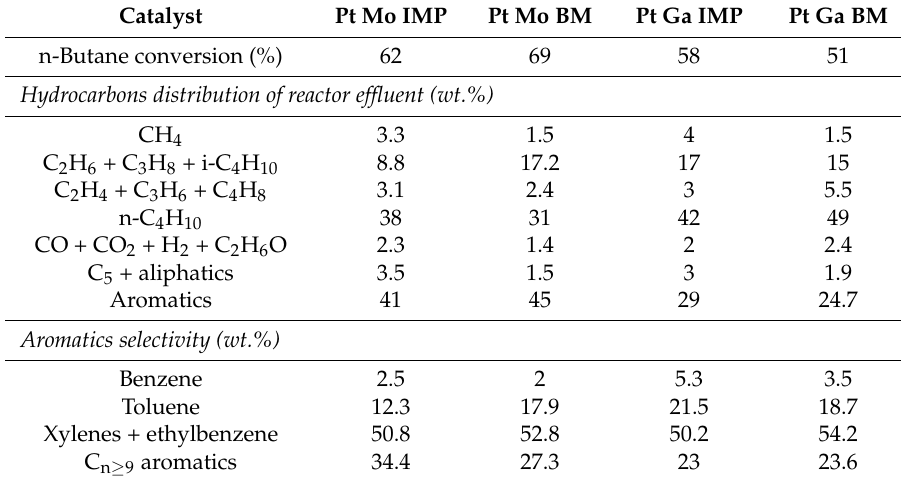
Table 2. Pt Mo/Ga catalysts performance in the aromatization of cofeeding n-butane with methanol. Catalyst Pt Mo IMP Pt Mo BM Pt Ga IMP Pt Ga BM n-Butane conversion (%) 62 69 58 51 Hydrocarbons distribution of reactor effluent (wt.%) CH 4 3.3 1.5 4 1.5 C 2 H 6 + C 3 H 8 + i-C 4 H 10 8.8 17.2 17 15 C 2 H 4 + C 3 H 6 + C 4 H 8 3.1 2.4 3 5.5 n-C 4 H 10 38 31 42 49 CO + CO 2 + H 2 + C 2 H 6 O 2.3 1.4 2 2.4 C 5 + aliphatics 3.5 1.5 3 1.9 Aromatics 41 45 29 24.7 Aromatics selectivity (wt.%) Benzene 2.5 2 5.3 3.5 Toluene 12.3 17.9 21.5 18.7 Xylenes + ethylbenzene 50.8 52.8 50.2 54.2 C n ≥ 9 aromatics 34.4 27.3 23